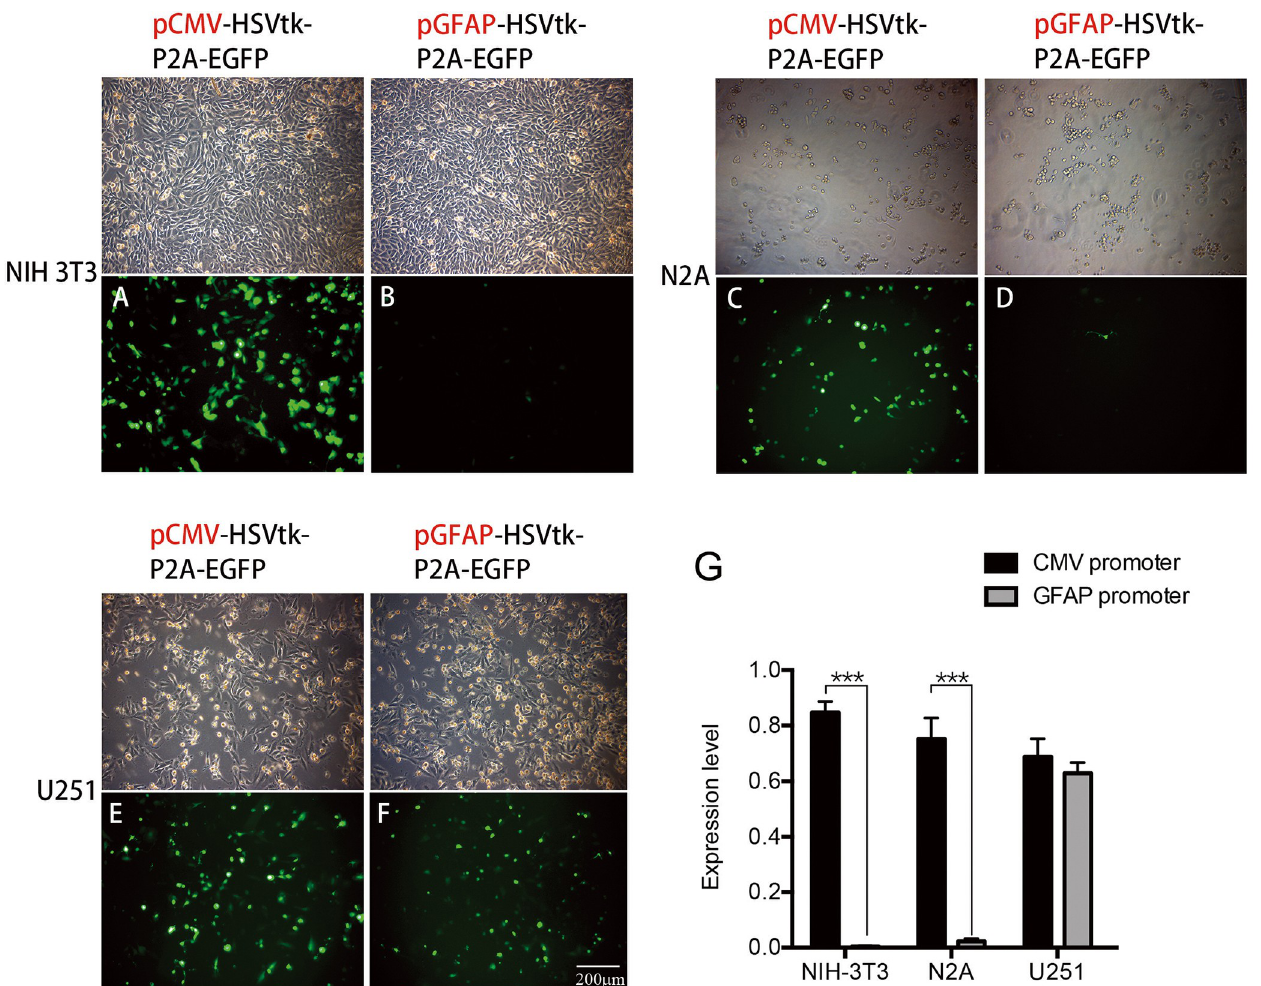
Fig 1. Expression levels of CMV and GFAP promoters in non-glial and glioblastoma cell lines. (A) Three cell lines—NIH-3T3, N2A, and U251—were transiently transfected with pCMV-HSVtk-P2A-EGFP or pGFAP-HSVtk-P2A-EGFP, and EGFP-positive cells were observed under an inverted fluorescence microscope. (B) NIH-3T3 had a strong expression level when transfected with the control plasmid, pCMV-HSVtk-P2A-EGFP. No NIH-3T3 cells expressed EGFP when transfected with pGFAP-HSVtk-P2A-EGFP. (C) A strong EGFP expression level was detected in N2A cells transfected with pCMV-HSVtk- P2A-EGFP. (D) Very few EGFP-positive cells were identified in N2A cells transfected with pGFAP-HSVtk-P2A-EGFP. Many EGFP-positive cells were observed in U251 cells transfected with pCMV-HSVtk-P2A-EGFP (E) or pGFAP-HSVtk-P2A-EGFP (F). Scale bar, 200 μ m. (G) The proportion of EGFP- positive cells from all live cells was calculated as the expression level of the promotors (n = 5). There was no significant difference in the expression level of NIH-3T3, N2A, and U251 cell lines when transfected with pCMV-HSVtk-P2A-EGFP. By contrast, the expression level of pGFAP-HSVtk-P2A-EGFP was significantly higher in U251 cells than in NIH-3T3 or N2A